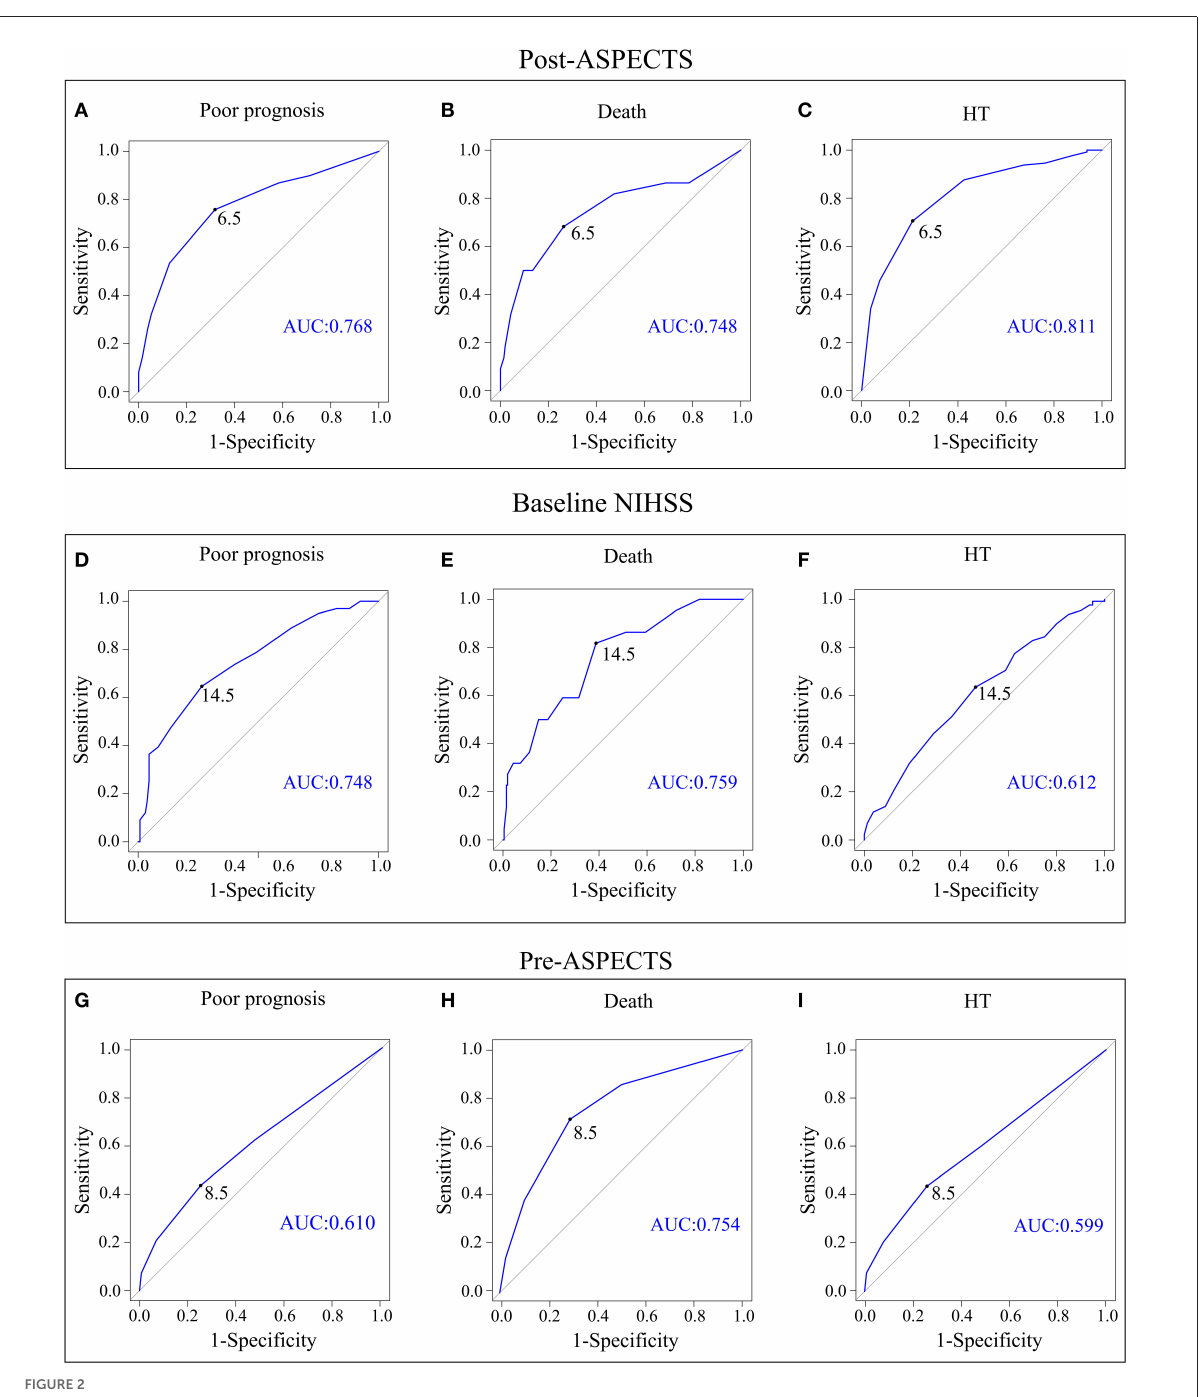
Age, collateral circulation, OTP time, and OTR time can all affect outcomes after thrombectomy (11, 22). Preoperative stroke severity is another indicator of clinical outcomes, and